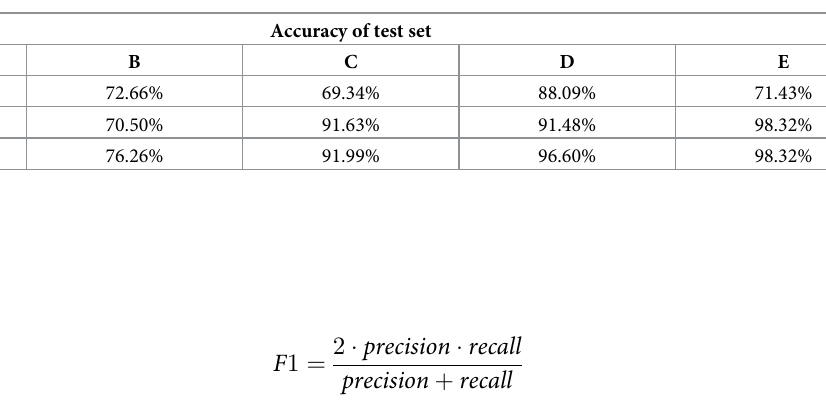
Table 6. Various types of recognition.